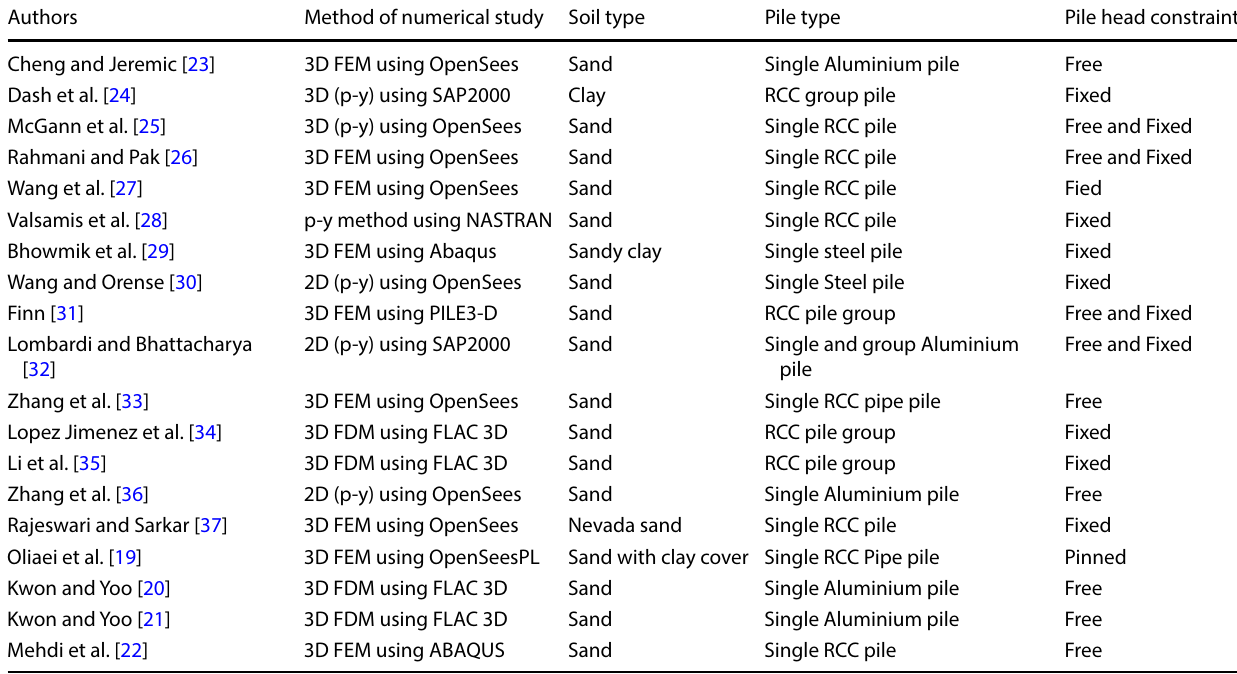
Table 1 Brief of latest numerical studies of pile foundations in liquefiable soil